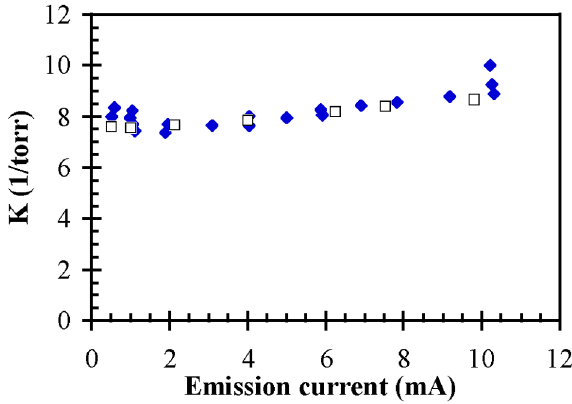
FIG. 8. (Color) The GESD Bayard-Alpert ion gauge is cali- brated by comparison with a Granville Phillips Stabil-Ion gauge at two pressures: (blue diamonds) 6 : 5 (cid:9) 10 (cid:10) 7 torr and (open squares) 2 : 5 (cid:9) 10 (cid:10) 6 torr .